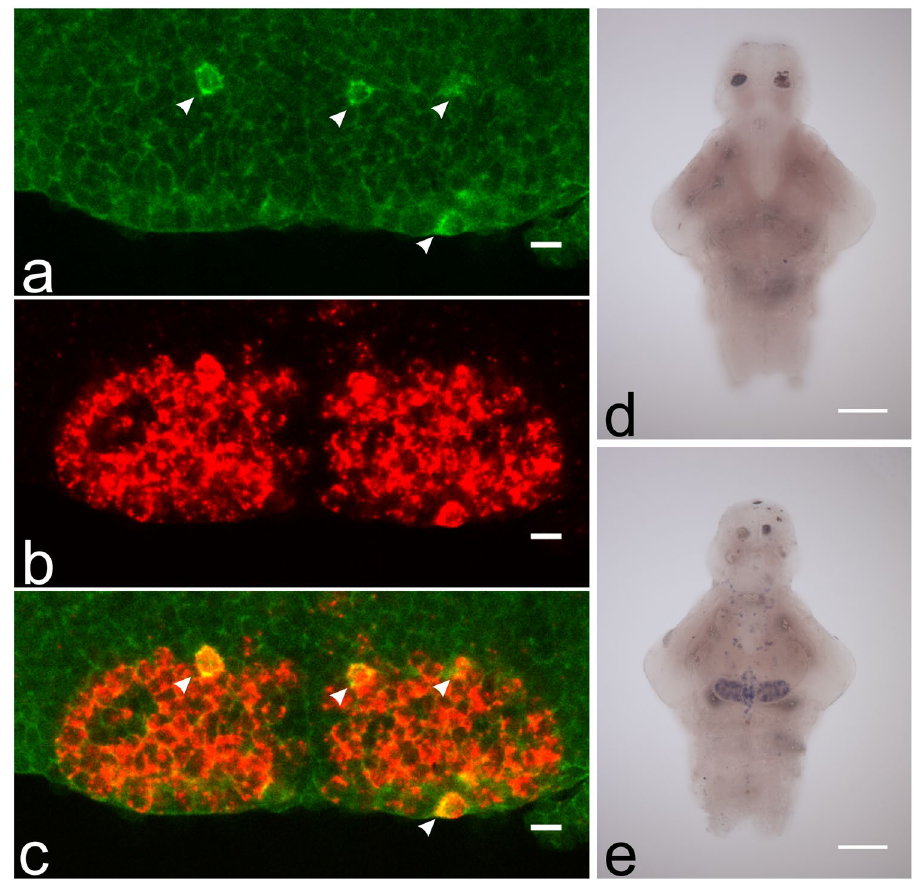
Figure 5. Expression of vmat1 , vmat2 and hdc in the hypothalamus. Virtually all hdc mRNA positive neurons seen (green, pointed out by white arrows) also express vmat2 mRNA (red) ( a – c ). n = 6 brains, representative single optical sections from one sample are shown. Red signal is developed using TAMRA tyramide and green signal using DY-647P1 tyramide. We found no expression of vmat1 in the zebrafish brain ( d ), although vmat2 was present in multiple brain regions ( e ). Scale bar 10 µ m for ( a – c ) and 100 µ m for ( d – e